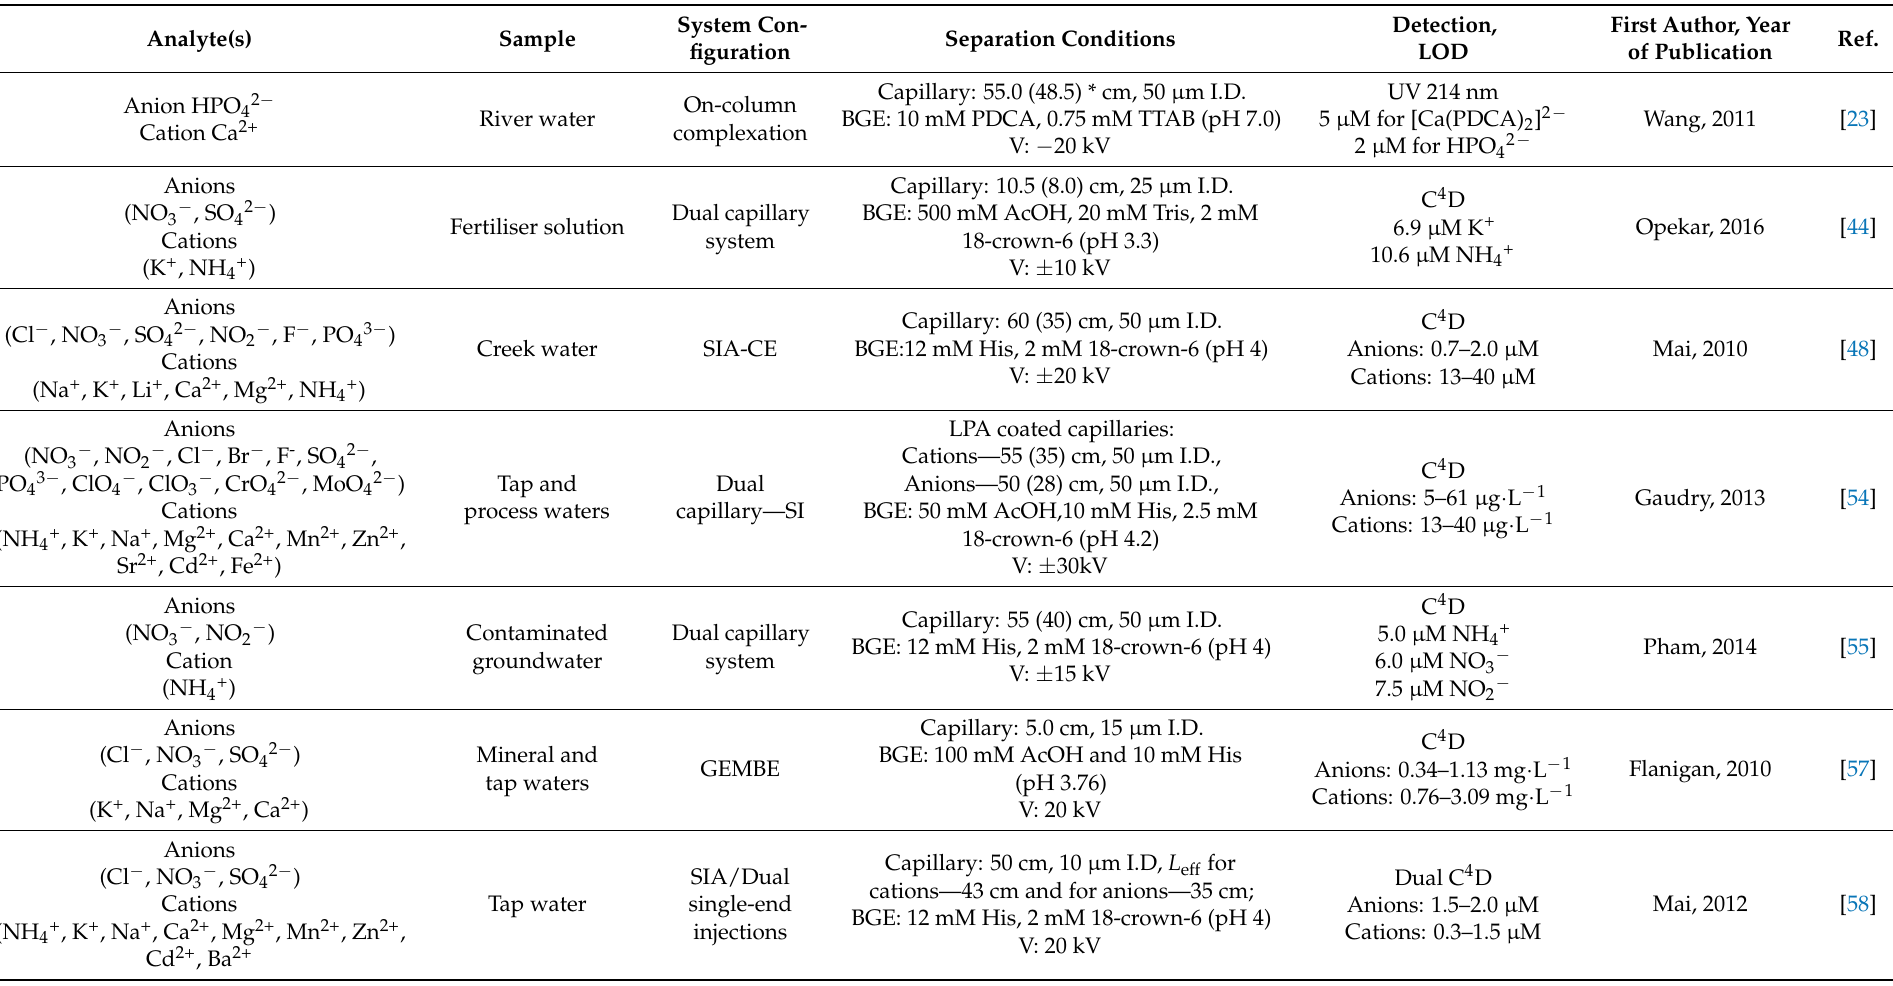
Table 2. Capillary electrophoretic methods developed for simultaneous determination of inorganic anions and cations in waters. Analyte(s) Sample